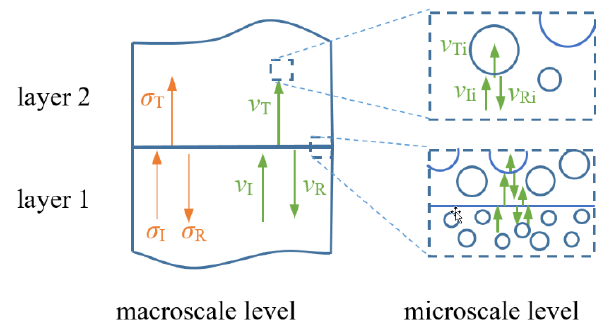
Figure 9. Velocity and stress at discontinuity.